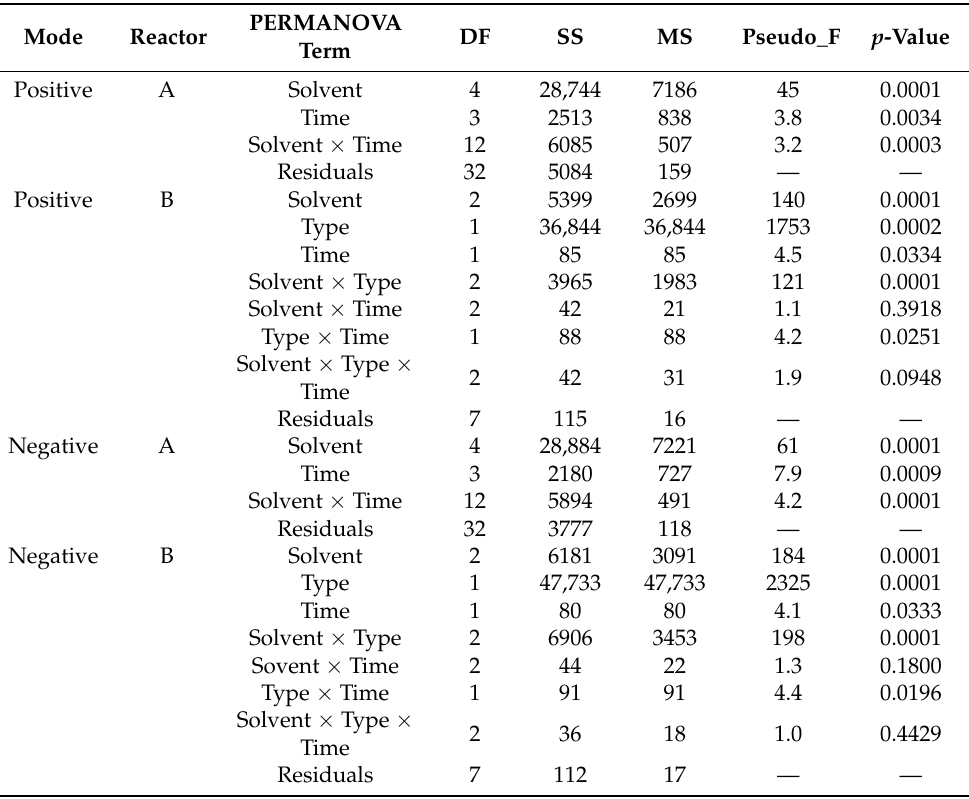
Table 1. PERMANOVA summary of fixed terms (experimental stages *) in the model for positive mode data in Reactor A and B.